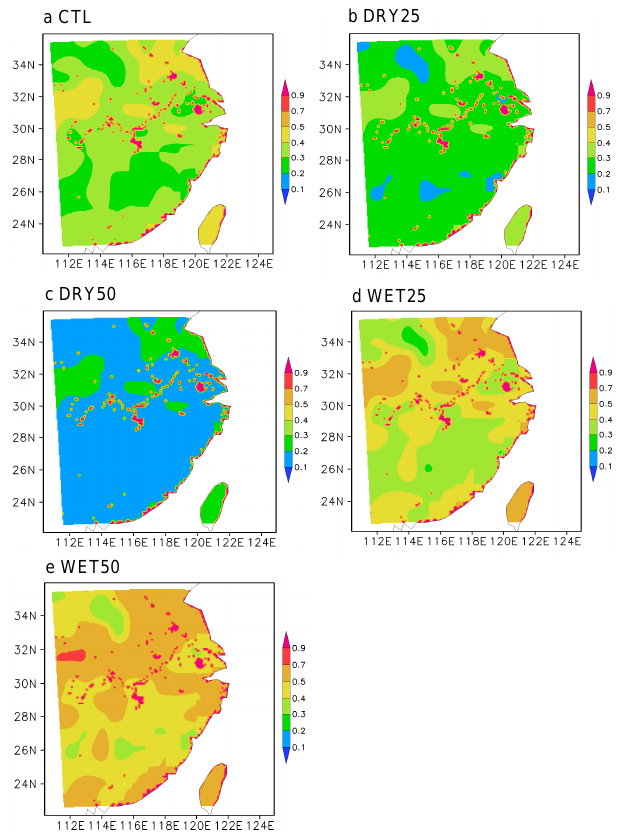
Figure 2. The initial surface soil moisture fields at 06:00UTC 20 July 2003 in the D21 simulations (units: m 3 m − 3 )